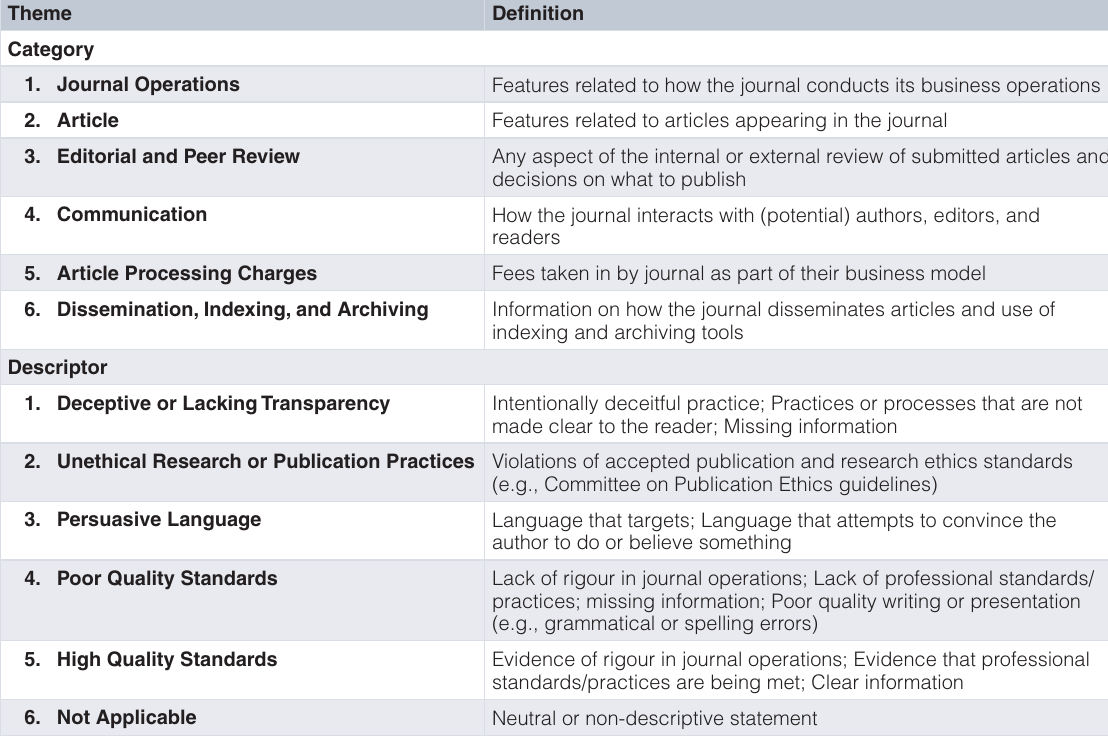
Table 3. Themes and Definitions used to Code Characteristics of Predatory